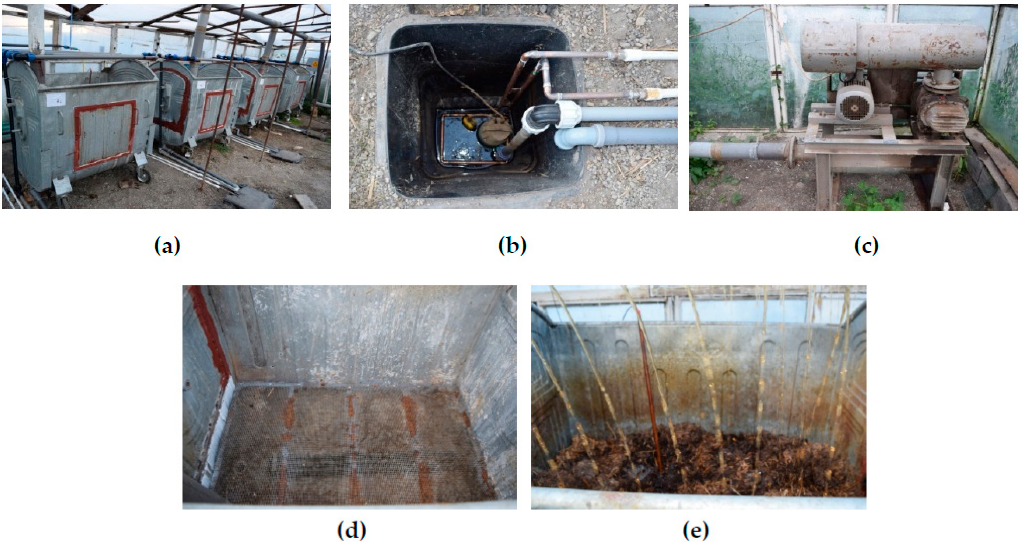
Figure A2. Sketch for the composting facility: (a) Composting facility—4 modules; (b) tank for the collection and recirculation of the water excess, built underground; (c) compressor for the air flow; (d) tank for composting, internal view; (e) compost components pre-soaking [68]. Source: Photo